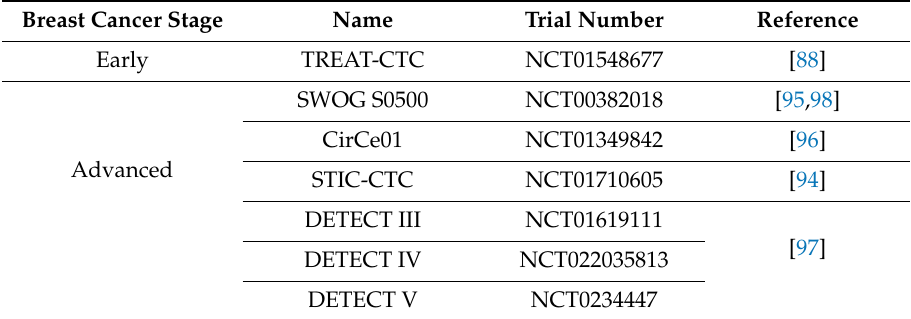
Table 1. Clinical trials investigating CTC role in treatment decision in early and advanced breast cancer described in this